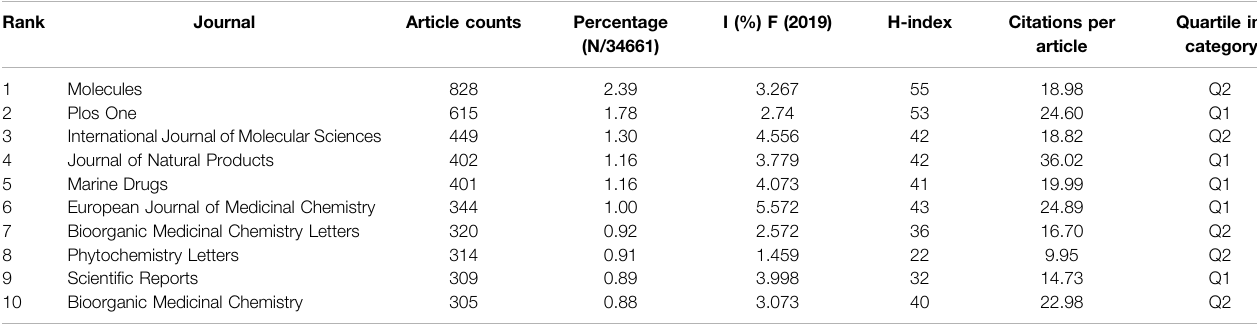
TABLE 3 | The top 10 productive journals related to natural products in cancer